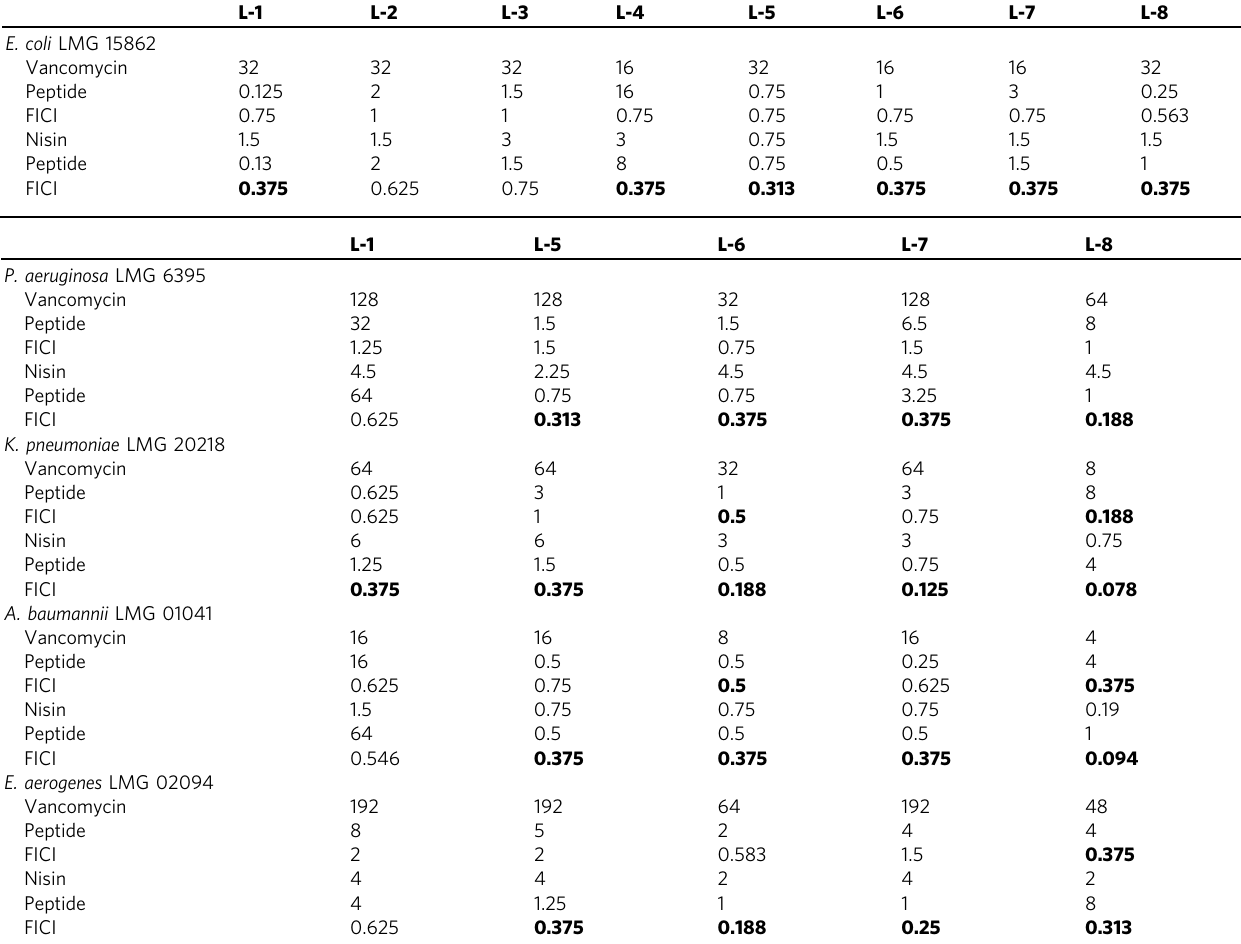
Inthe tablearelistedtheMICs( µ M) forvancomycin,nisinand thepeptidesforthebest combination,aswellastheFICI calculation.Foran explanationof FICIandhow itiscalculatedseethe “ Methods ” section. Synergistic combinations are labeled in bold. For the FICI calculations twice the highest concentration tested was used in the cases where the MIC was not reached. Individual MICs are listed in Table